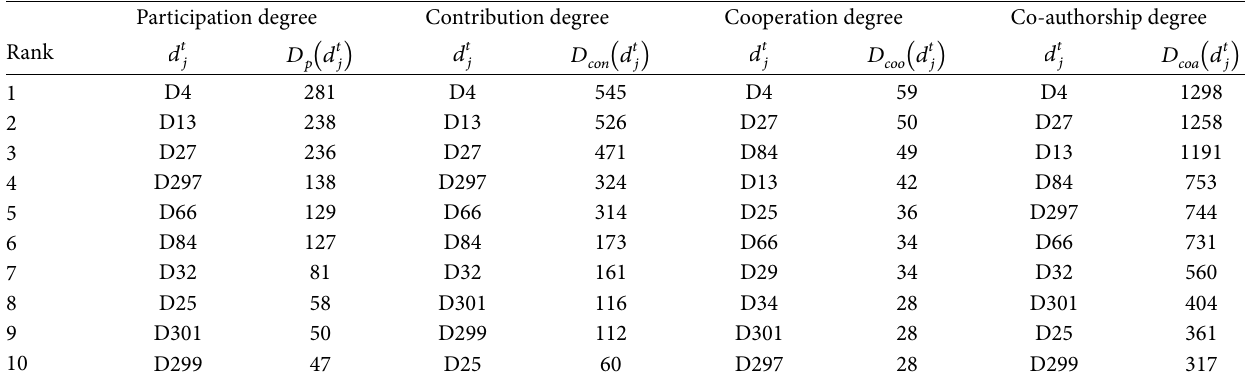
Table 9: The top ten drafters with high indicators in TD-SCDMA system.